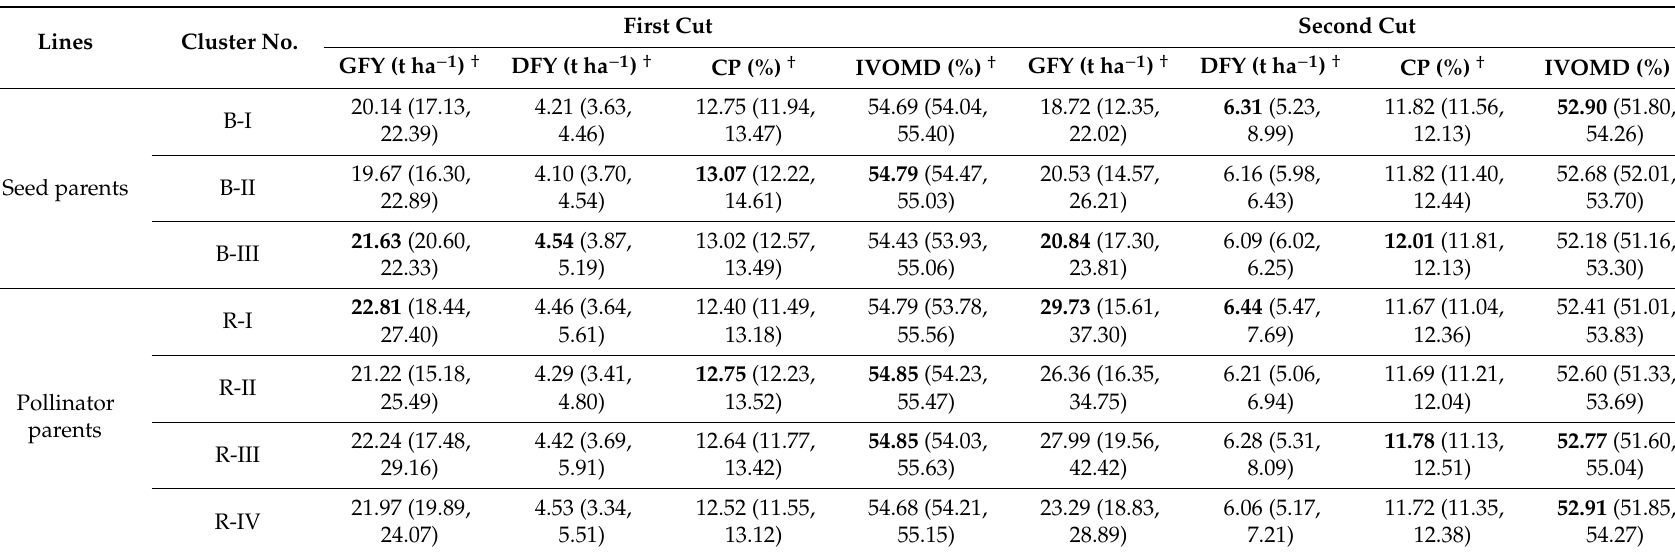
Table 3. Mean values for forage traits in di ff erent SSR-based clusters on the basis of 2 year data (Summer season at ICRISAT, 2015 and 2016). Lines Cluster